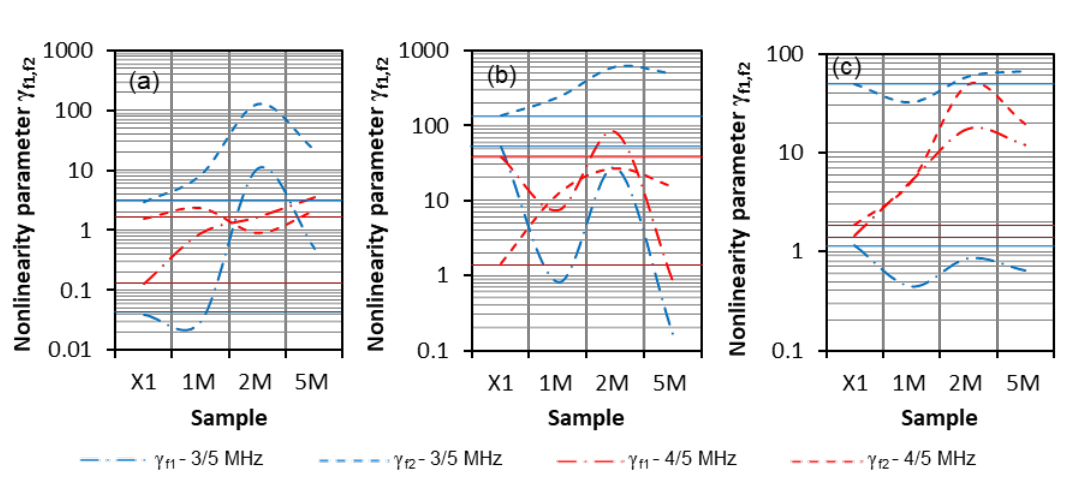
γ γ α = 50 ◦ ; ( b ) α = 60 ◦ ; ( c ) α = 90 ◦ f 1 and f 2 parameters: ( a )